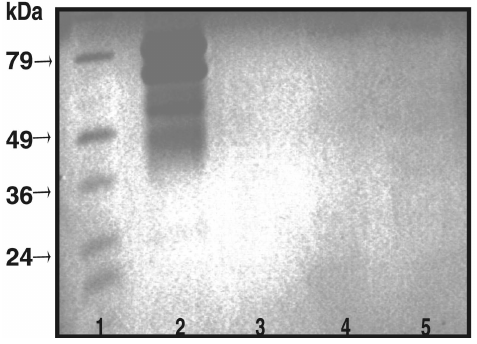
Figure 9. The activity of multiple NADH oxidases is abolished by treatment with protease. Whole cells of A. fulgidus were separated by SDS-PAGE, renatured and assayed for NADH oxidase activity as de- scribed in Materials and methods. Lane 1: prestained protein stan- dards; Lane 2: untreated whole cells; Lane 3: whole cells treated with protease for 10 min; Lane 4: whole cells treated with protease for 20 min; Lane 5: whole cells treated with protease for 30